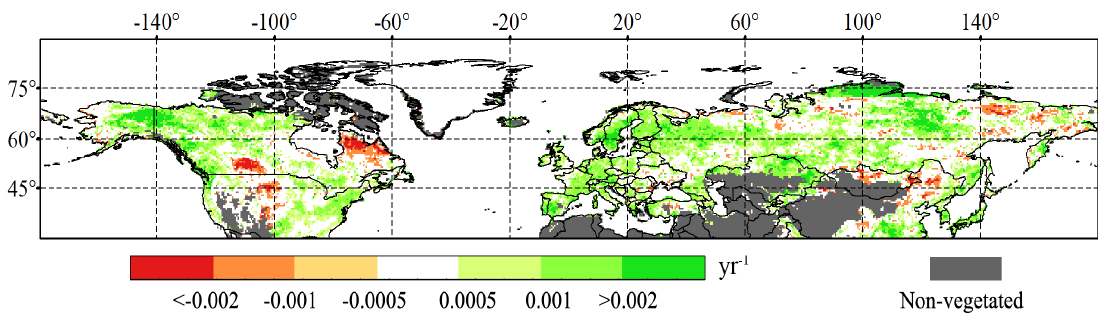
Figure 4. Differences between NDVI3g and NDVIg in the overall changing trends of growing-season NDVI during